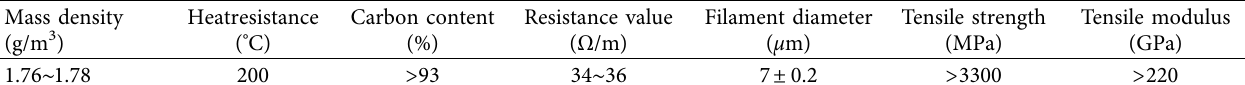
Figure 3: 12 K carbon fiber heating wire. Table 1: Performance of 12K carbon fiber heating wire.